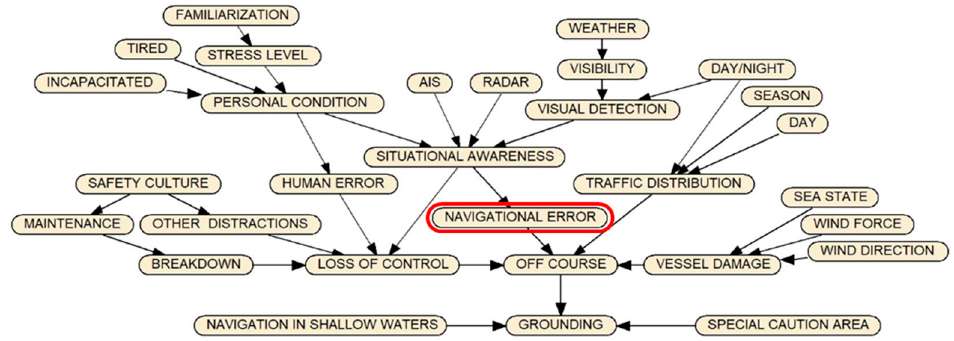
Figure 13. Visualization of the accident contributing candidate for “Cicero”.